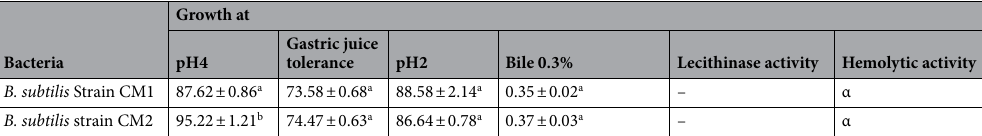
Table 3. The culture results for selected isolates from camel milk in different conditions. Data for three replications are presented as mean ± SD. Mean within the same column followed by different supercript letters differ significantly (P <